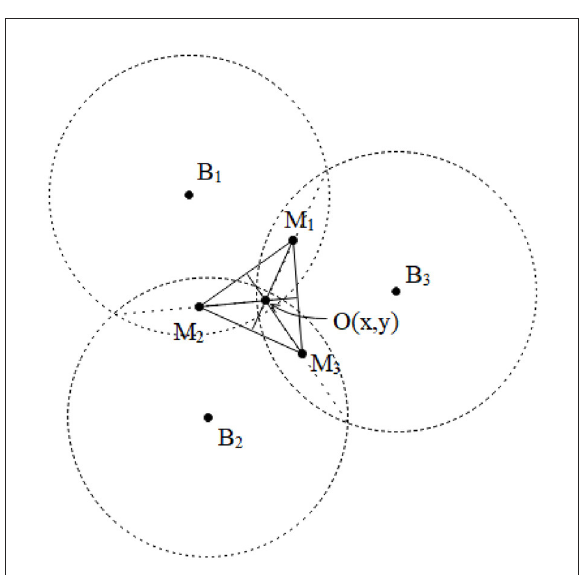
FIGURE3 Principle of improved trilateral positioning algorithm.